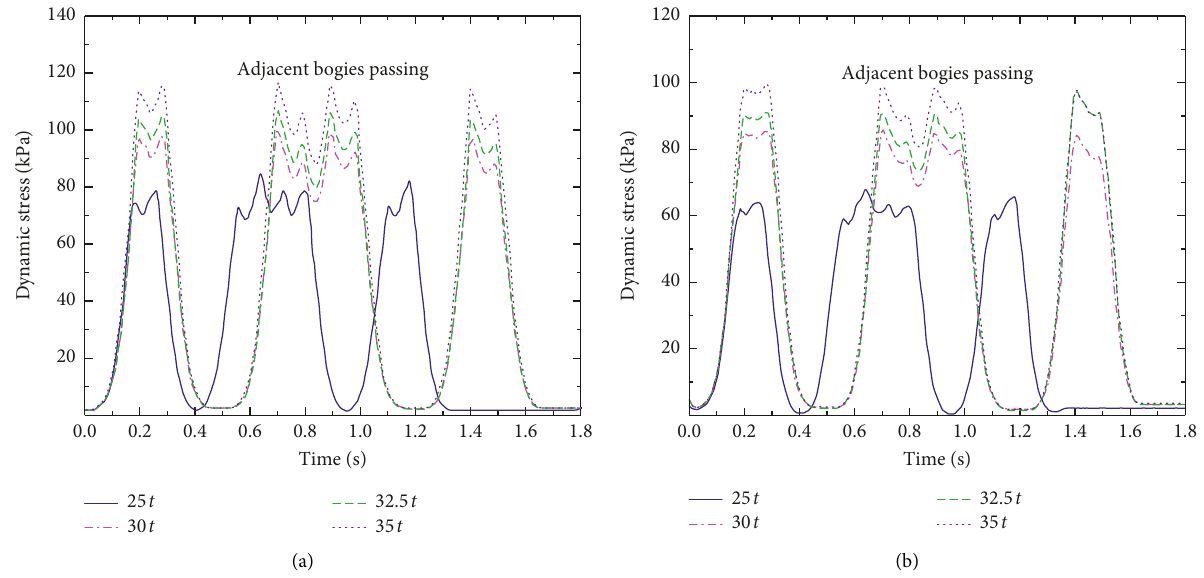
Figure 12: Dynamic stress at the subgrade surface: (a) below the rail; (b) below track centerline.